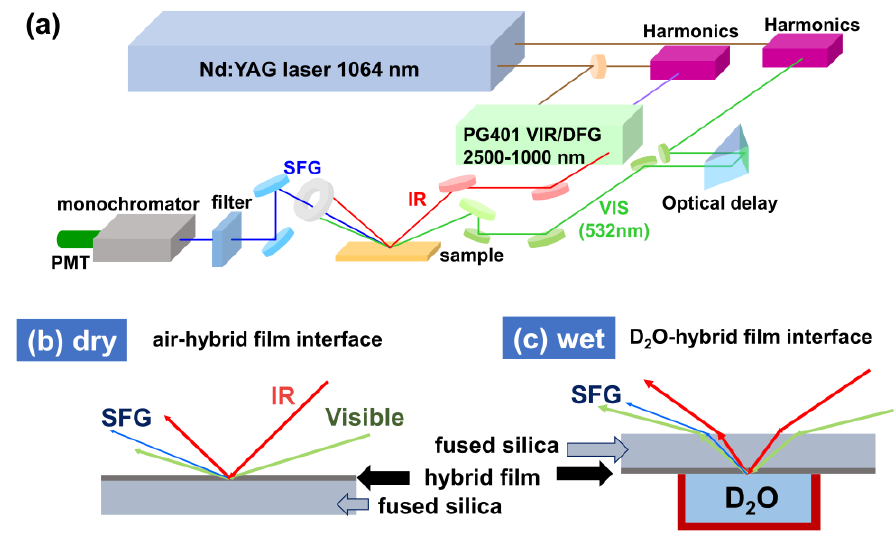
Figure 1. ( a ) Schematic illustration of the optical setup of the SFG, and SFG measurements under ( b ) dry and ( c ) wet conditions.